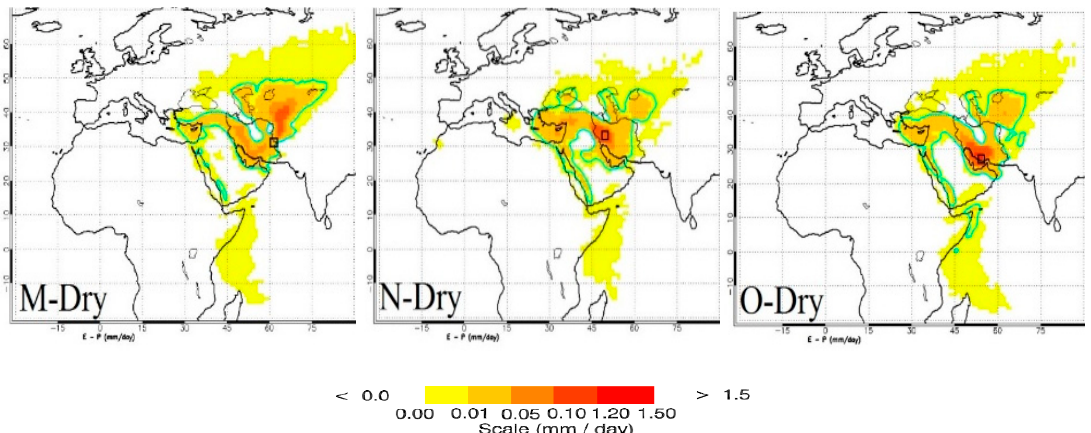
Figure 5. (E-P) backward models in 15 sub-regional locations (from ( A – O )) for the dry season. The light green line shows the boundaries of 95 percentiles of (E-P) > 0.